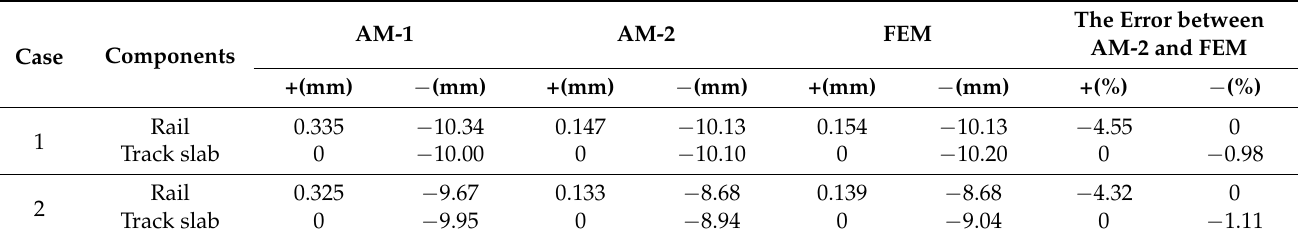
Table 2. The maximum and minimum rail mapping deformation in the two